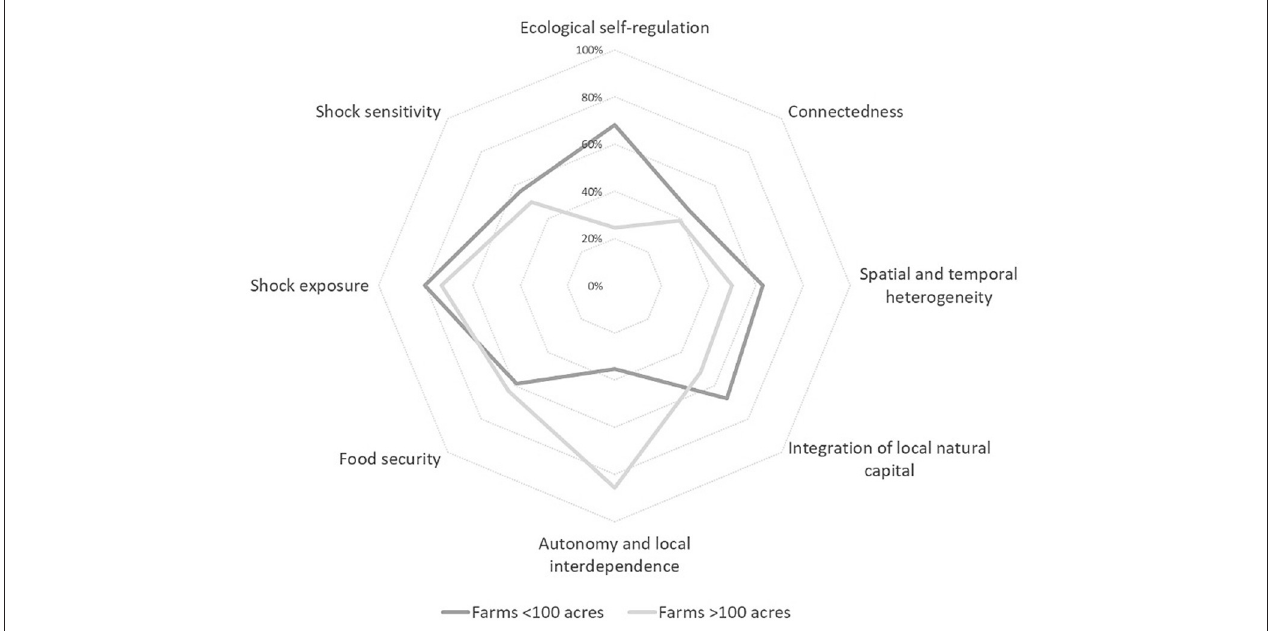
FIGURE 7 | Assessment of the perceived resilience of the participating farms ( n = 53) divided into farms larger and smaller than 100 acres based on Cabell and Oelofse (2012) framework and additional food system resilience parameters (Ericksen et al., 2012; Intergovernmental Panel on Climate Change, 2014), 100% represents the highest